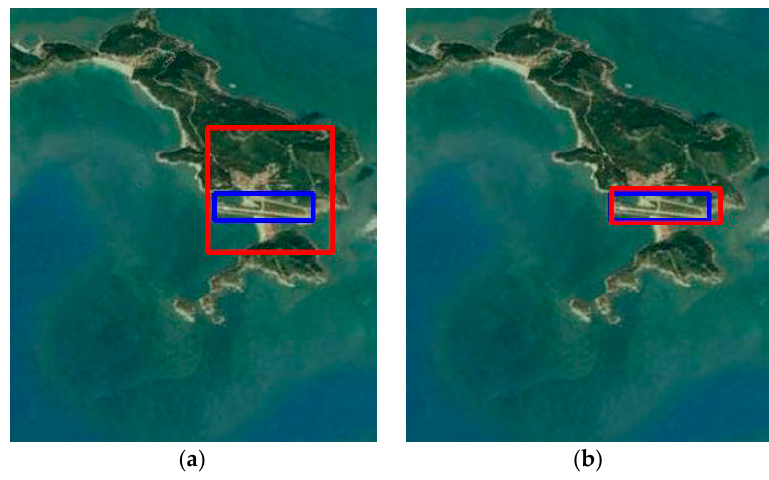
Figure 2. Positive samples at different scales: ( a ) scale of 128 2 ; ( b ) scale of 64 2 . The bounding box of the airport is shown by the blue rectangle, and the positive sample is shown by the red rectangle. [Image courtesy of Google Earth].